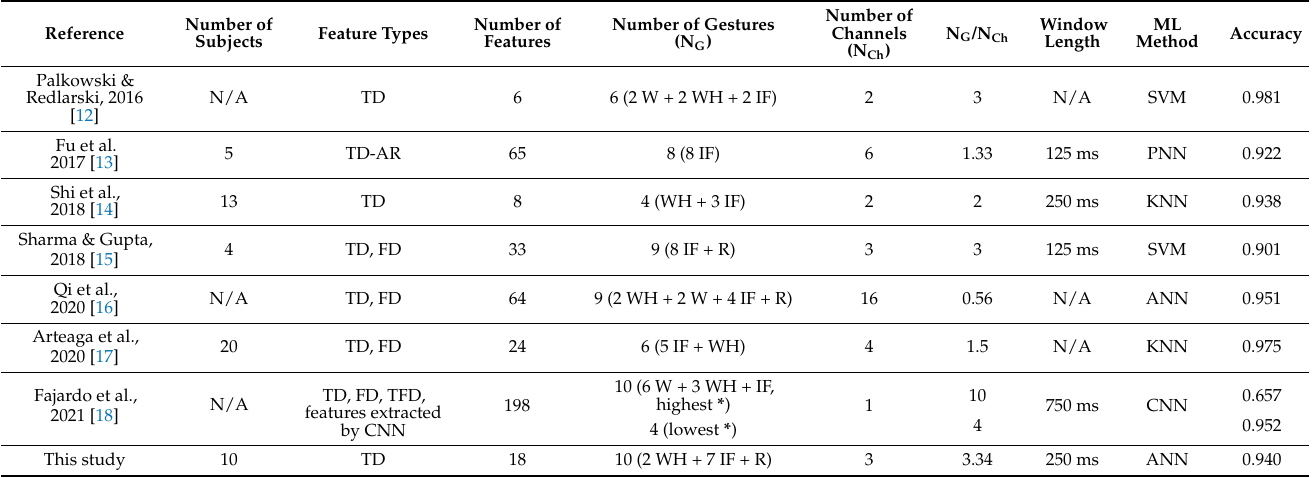
Table 6. Recent EMG-based hand/finger gesture recognition studies that used TD features and focused on IF gestures. Studies that used commercially available multi-channel wearable devices were